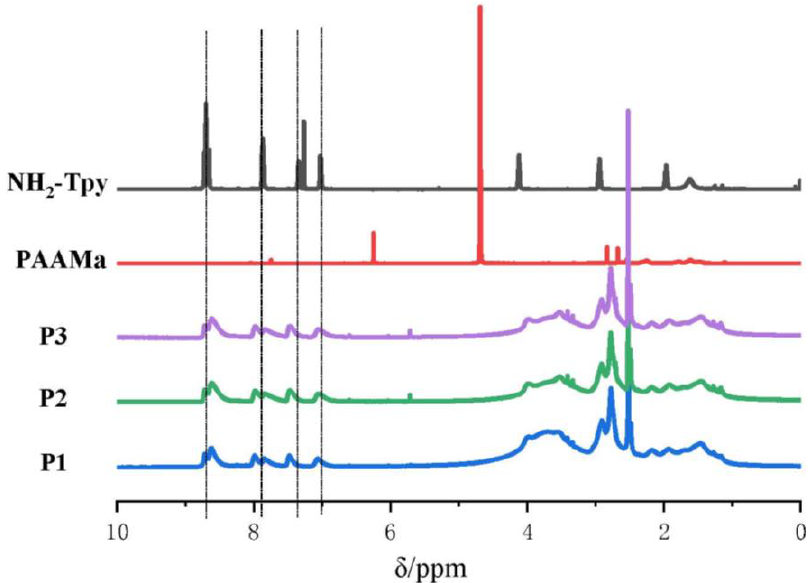
Figure 2. The NMR spectra of NH 2 -Tpy , PAAMa , and the polymers P1 , P2 , and P3 . According to the integrating area of the NMR spectra, the content of the terpyridine segments in the resulting polymers ( PAAMa ) can be calculated, and the results obtained from NMR peaks and the feed percentage of the terpyridine-containing monomer NH 2 -Tpy are summarized in Table 1. As shown in Table 1, the feed percentage of NH 2 -Tpy was close to the content of terpyridine units calculated from NMR. Table 1. The feed content of monomer NH 2 -Tpy , and the content of terpyridine segments calculated from the NMR integrating area and the conversion rate of the radical polymerization for P1 , P2 , and P3 .